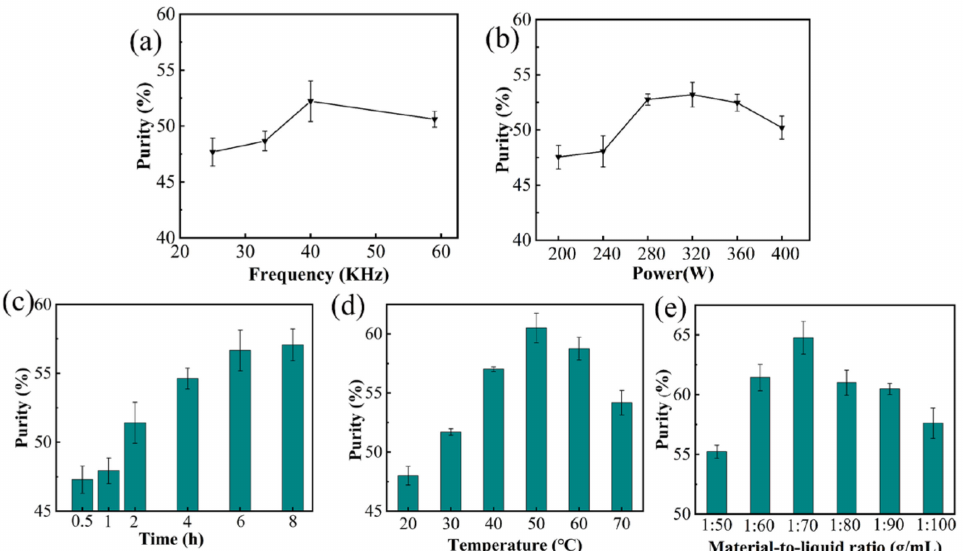
Figure 3. Effect of different ultrasonic parameters on the purity of gutta-percha. ( a ) frequency, ( b ) power, ( c ) time, ( d ) temperature, ( e ) material-to-liquid